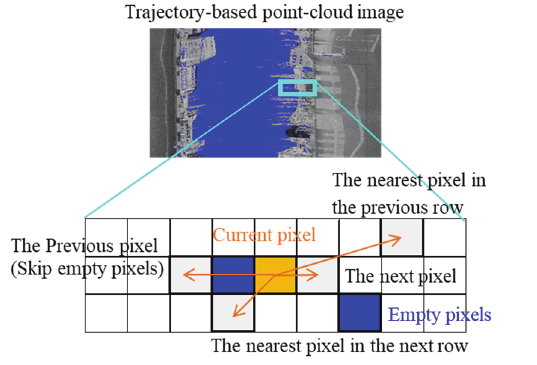
Figure 4 . Convert to wireframes by point-cloud image